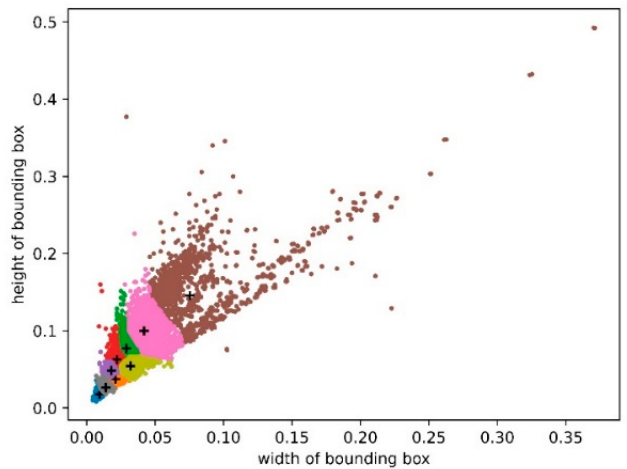
Figure 9. Distribution of clustering centers in the CCTSDB2021 dataset.